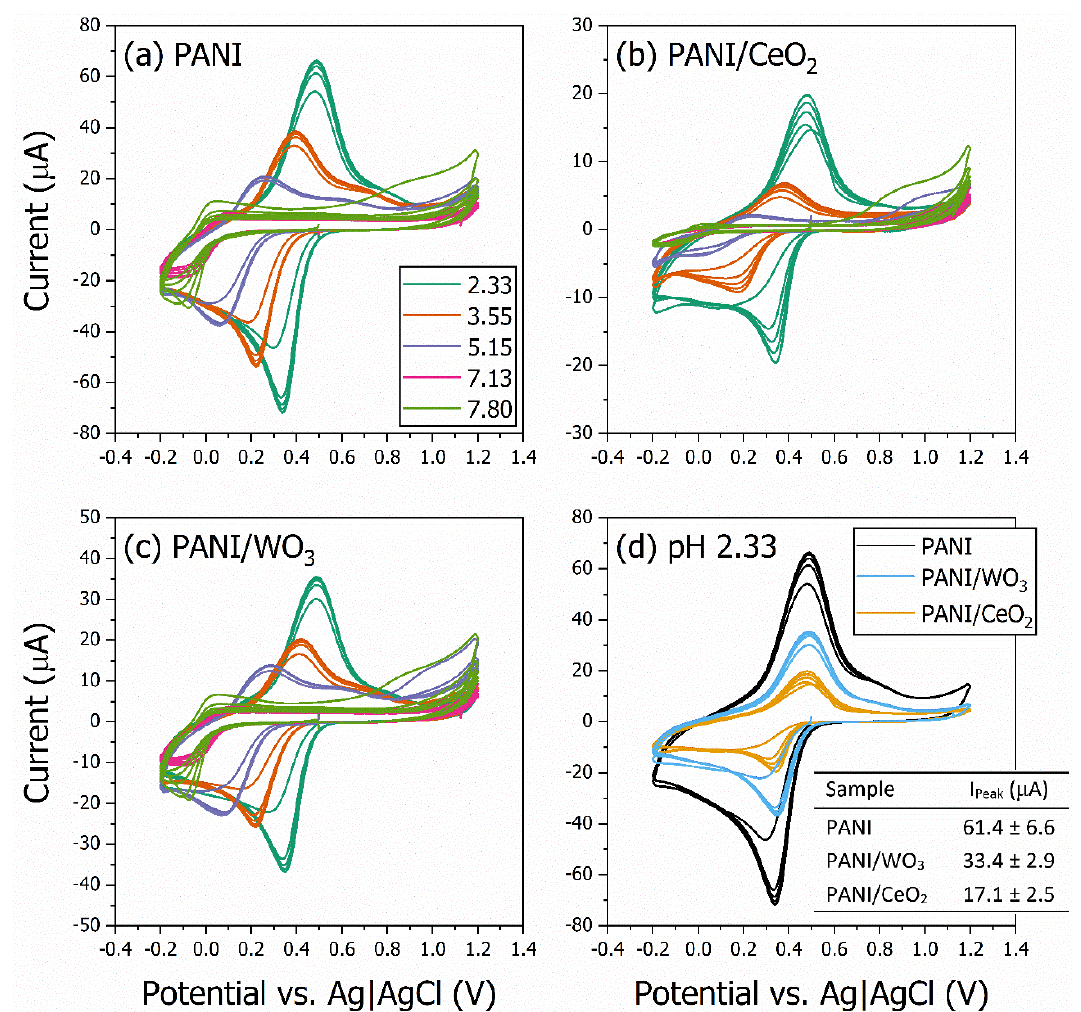
Figure 2. Cyclic voltammetry findings collected in different pH buffer electrolytes used as working electrode FTO substrates modified with: ( a ) PANI, ( b ) PANI/CeO 2 , and ( c ) PANI/WO 3 nanocomposites. The reversible redox peaks of PANI-based materials are present. The peak current is proportional to the buffer solution pH. In ( d ), the cyclic voltammograms of the three samples are compared for the same buffer solution with a pH of 2.33. The inset shows the table with the peak currents. The I Peak is influenced by the composite composition.